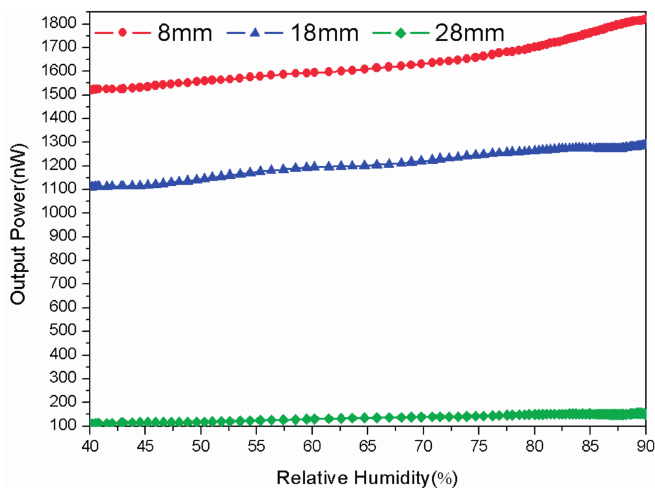
Figure 4. The humidity response of the proposed sensor with different radiuses.